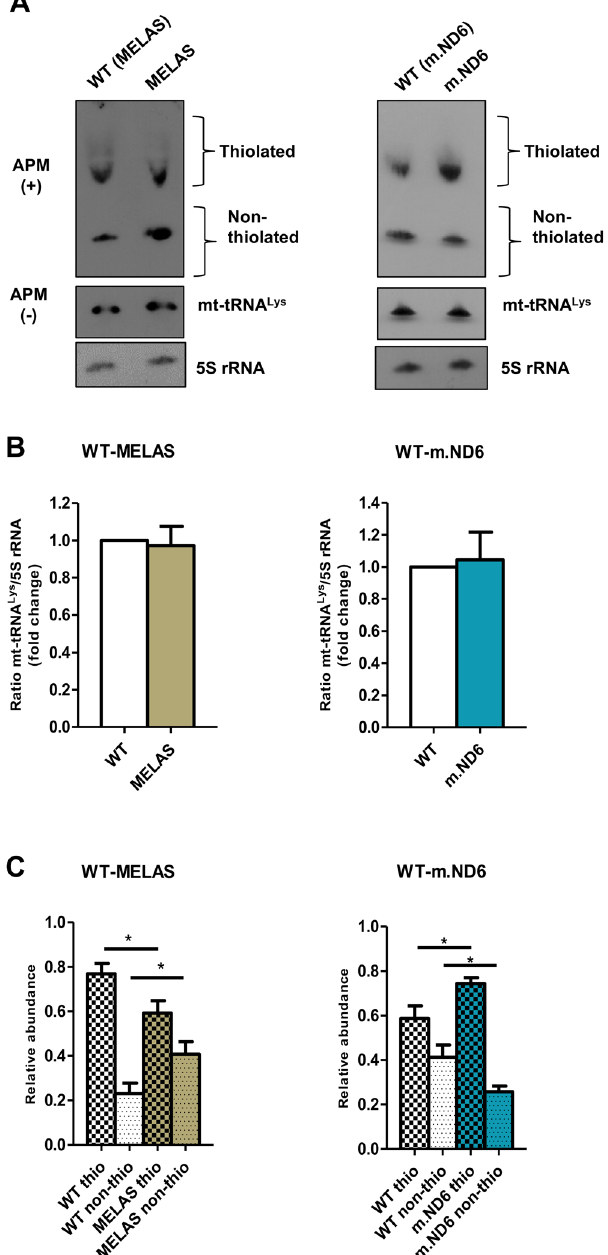
Figure 3. The 2-thiouridylation status of mt-tRNA Lys depends on the TRMU expression level. ( A ) APM- Northern analysis of the 2-thiolation status of mt-tRNA Lys obtained from mutant and WT cybrid cells. The same amount of total RNA (7.5 µ g) was run in a denaturing polyacrylamide-urea gel in the presence ( + ) or absence ( − ) of APM. The thiolated tRNAs were detected as retarded bands in the presence of APM. The APM ( − ) membrane was also probed with 5S rRNA as a loading control. ( B ) Relative steady-state levels of mt-tRNA Lys . The signal corresponding to the amount of mt-tRNA Lys in the APM ( − ) membrane was normalized to the signal corresponding to the amount of 5S rRNA and represented as fold change relative to WT. Full-length blots and lower-exposure blots for the APM ( + ) membranes are included in supplementary information. ( C ) Percentage of thiolated and nonthiolated mt-tRNA Lys species compared with the whole amount of this mt-tRNA. The quantification of each fraction (thiolated or nonthiolated) is expressed as a percentage of its signal from the total signal (thiolated + non-thiolated signals). All data represent the mean ± SD of at least three different experiments. Differences from WT values were found to be statistically significant at * p <